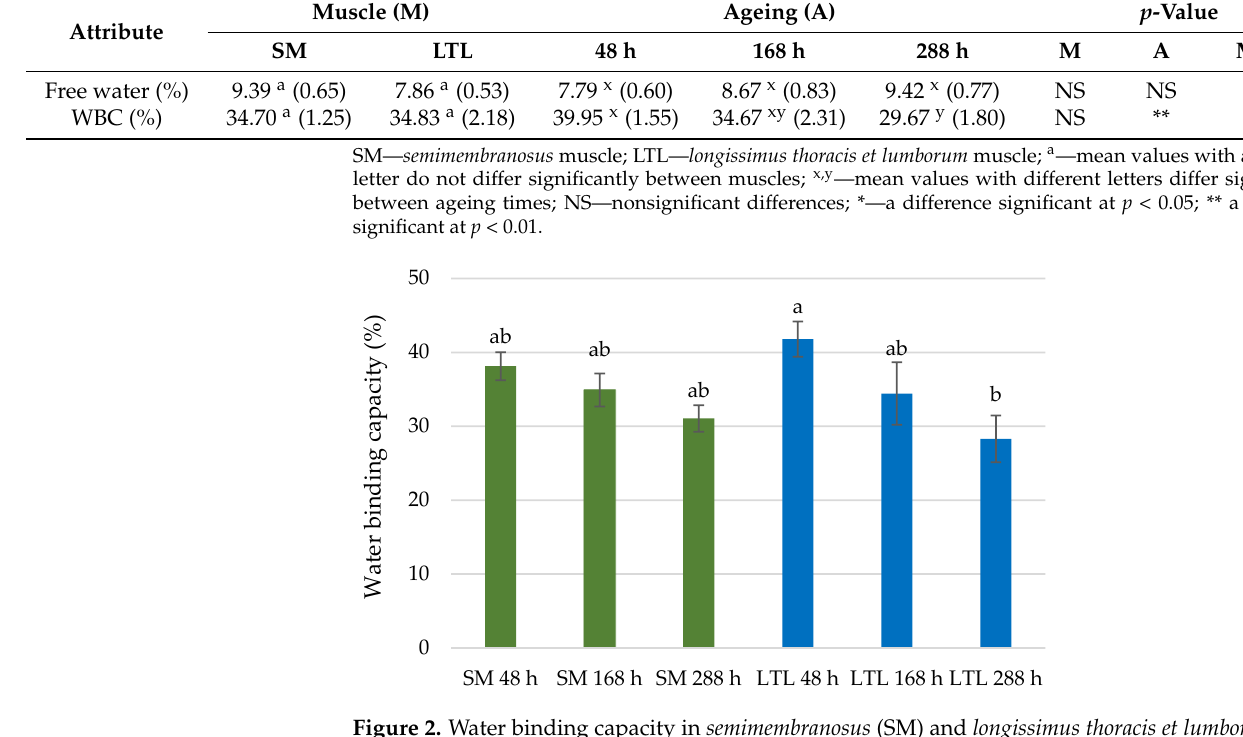
Table 1. The effect of muscle and ageing on free water content and water binding capacity (WBC) in Figure 1. Changes in pH during ageing of semimembranosus (SM) and longissimus thoracis et lumborum fallow deer meat (mean values and standard error of the mean in brackets). (LTL) fallow deer muscles. a–c—mean values with different letters differ significantly at p < 0.05.